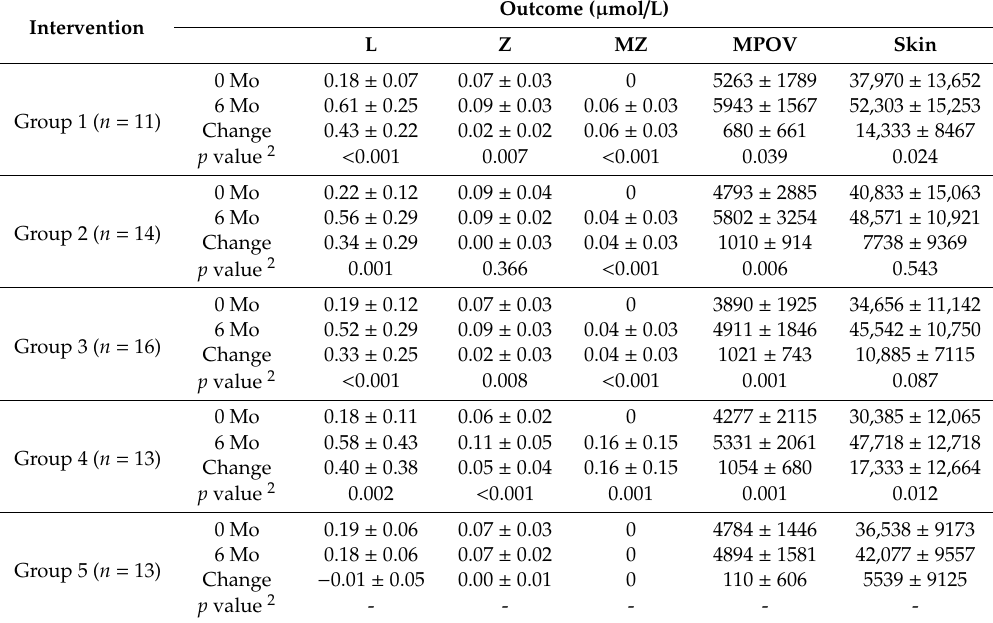
Table 3. Response in serum and tissue concentrations to di ff erent formulations of nutritional supplements with L, Z, and MZ compared to placebo 1 .